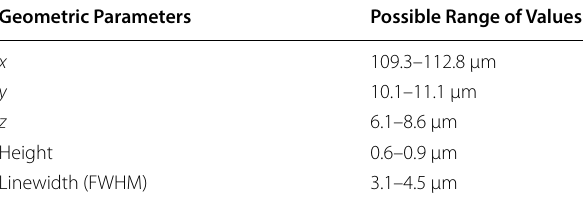
Table 1 Values for geometric parameters x–z of sub‑ structure design III depicted in Fig. 5a and height and linewidth values originating from AFM